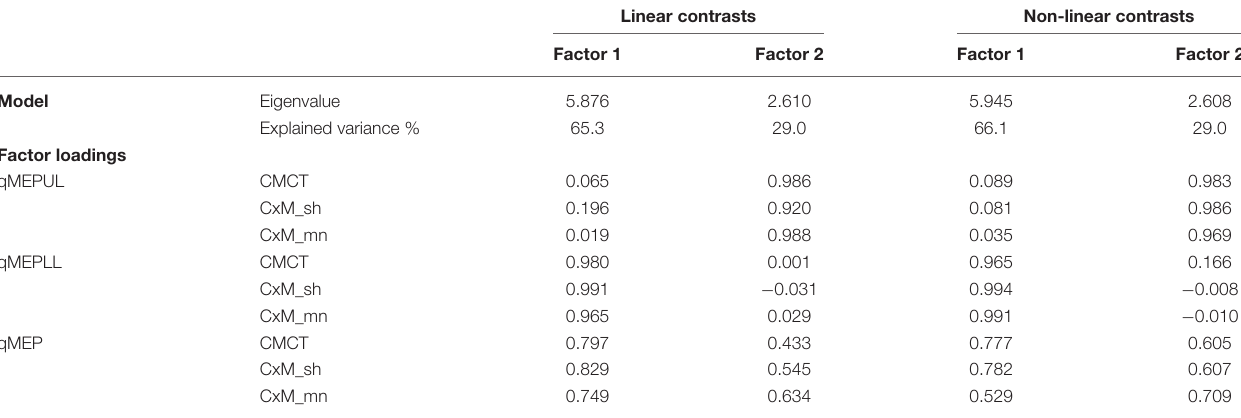
TABLE 3 | Factor analysis of longitudinal change in qMEP